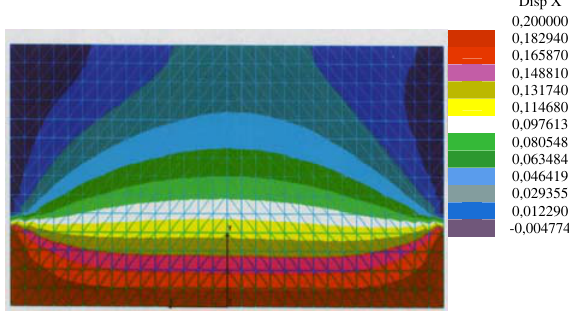
Fig 6 . Horizontal soil displacements x u distribution during shear box test using stiff stamp (linear model)